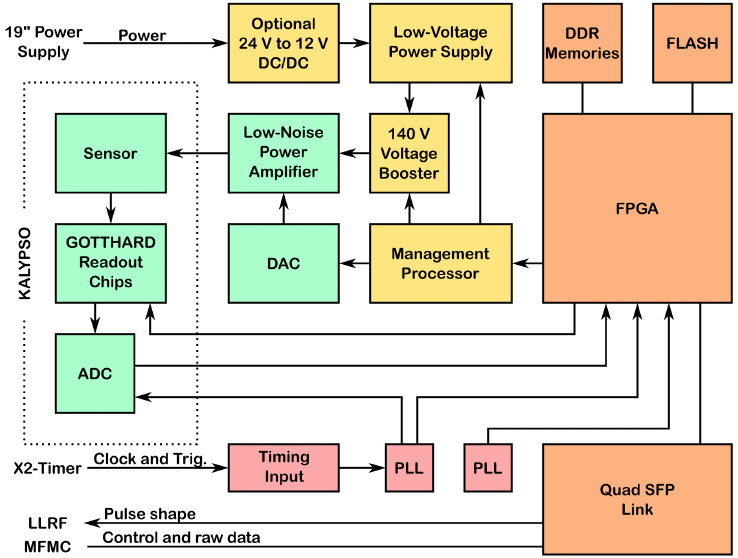
Figure 5. A block diagram of the data acquisition module.